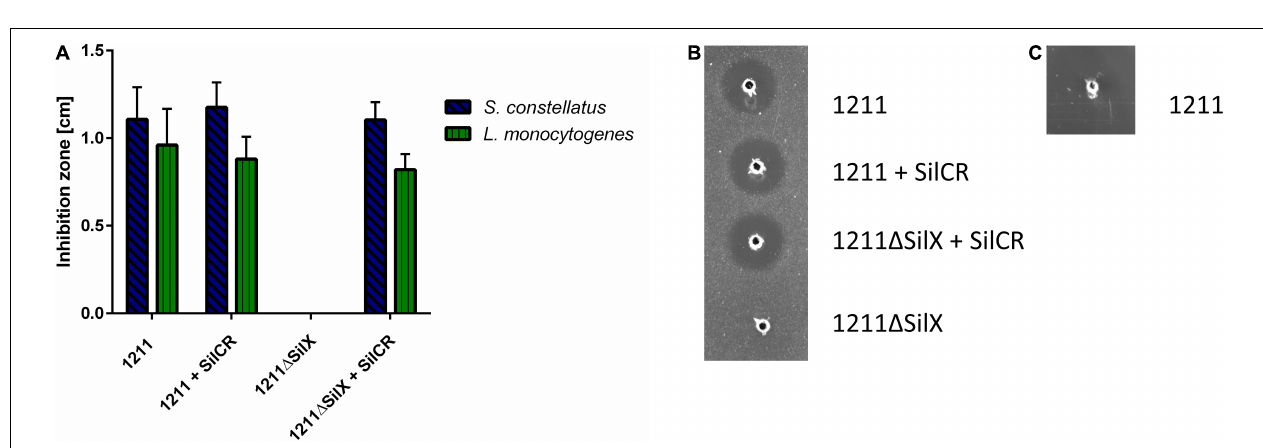
FIGURE 2 | HIV protease inhibitors inhibit Angicin activity of S. anginosus . The antimicrobial activity of S. anginosus BSU 1211 against S. constellatus and L. monocytogenes was tested in an RDA. S. anginosus BSU 1211 was supplemented with (A) Nelfinavir concentrations ranging from 25 to 250 µ M or (B) Saquinavir concentrations ranging from 100 to 500 µ M. Depicted is inhibition zone diameter ± standard deviation of at least five independent experiments. Significance was calculated using Mann-Whitney U test with * presenting a p -value < 0.5, ** indicating p < 0.01 and *** illustrating p < 0.001.